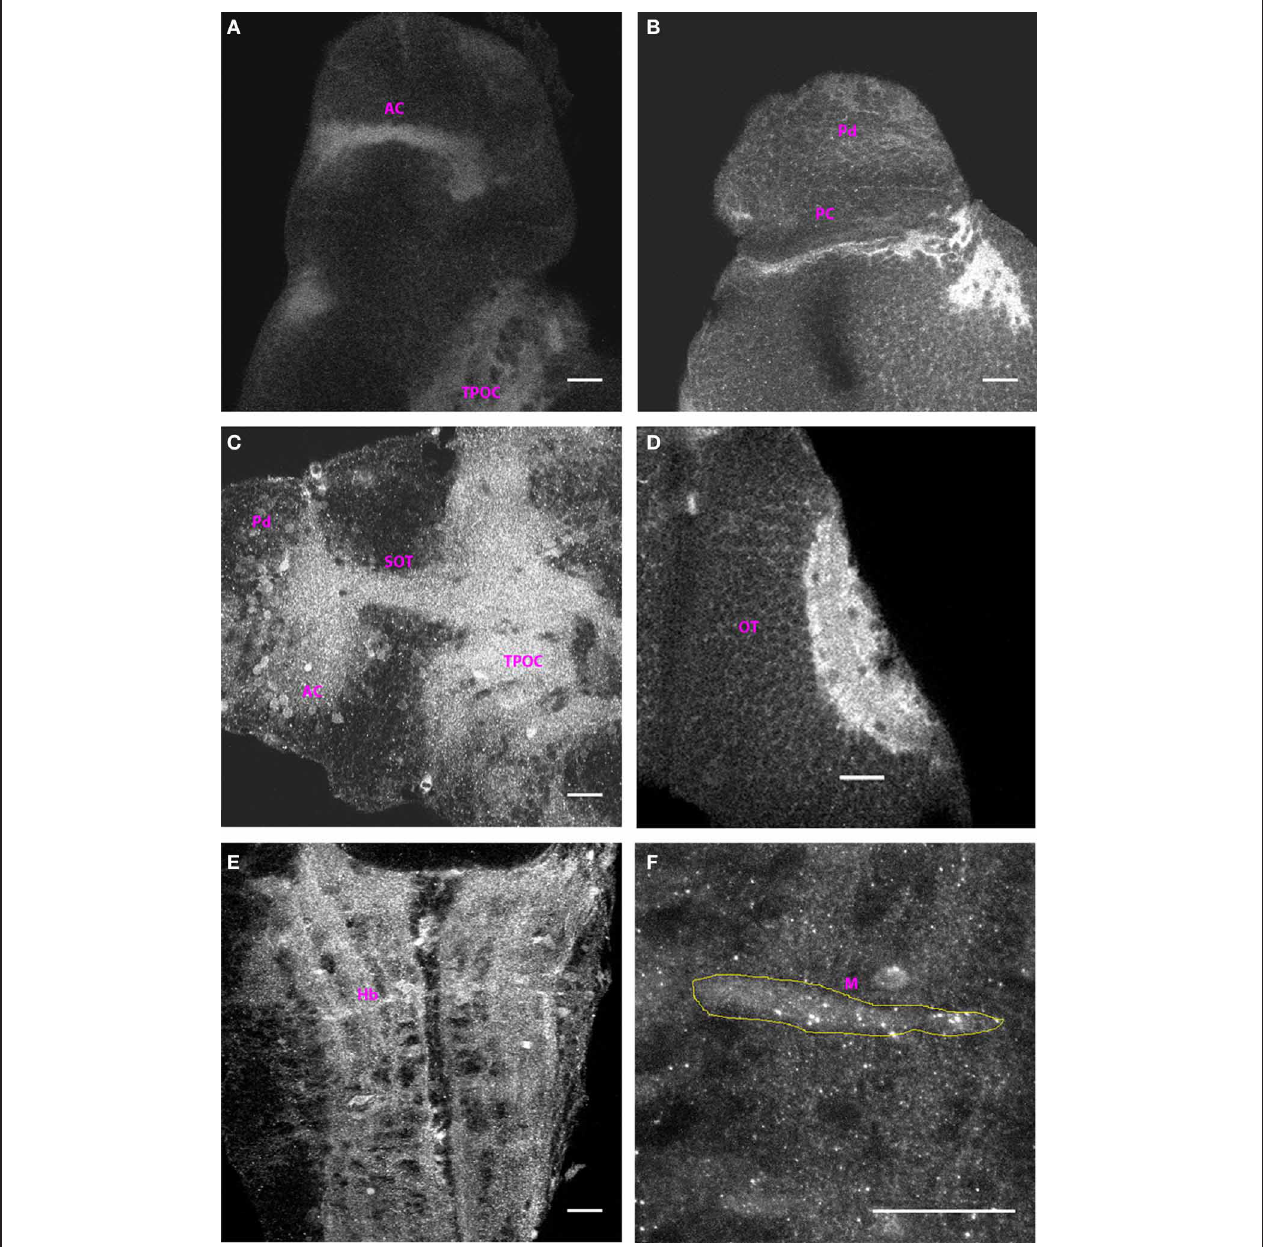
Cx35 immunoreactivity is seen in the anterior commissure, in the supra-optic tract and in thick fiber tracts in ventral diencephalon. Numerous cell bodies can also be seen in the vicinity of the anterior commissure. (D) Intense Cx35 immunoreactivity in the optic tectal (OT) neuropil. (E) Ventral hindbrain (Hb) showing fiber tracts criss-crossing the hindbrain. (F) Zoomed image of a single Mauthner neuron (M) showing intense Cx35 immunoreactive puncta. The approximate boundary of the Mauthner neuron as seen in DIC is shown in yellow. Scale bar for all panels: 20 µ